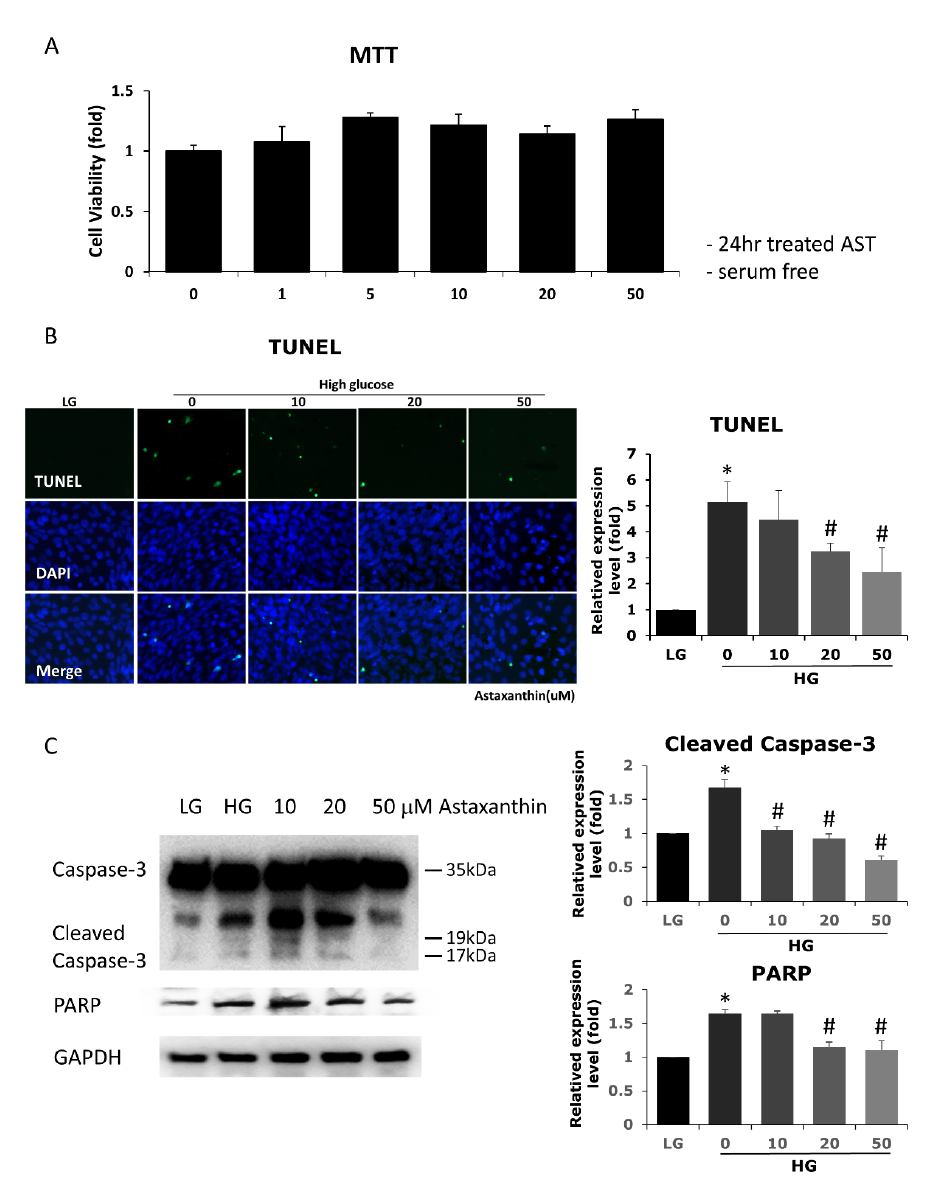
Figure 1. Effects of AST on cell viability and high glucose-induced apoptosis in 661W cells. ( A ) Cell viability was evaluated using MTT assay upon treatment with di ff erent concentrations of AST for 24 h. AST-treated and control cells showed similar cell viability. ( B ) Increased cell apoptosis was noted under high glucose environment, demonstrated by TUNEL assay and protein expression (western blots, C ). AST reduced apoptosis at 20 and 50 µ M concentration. ( C ) Decreased cleaved caspase-3 and PARP protein expression seen in western blots indicated that apoptosis was attenuated by AST. AST = astaxanthin; HG = high glucose; LG = low glucose; MTT = 3-(4,5-dimethylthiazol-2-yl)-2,5-diphenyltetrazolium bromide; TUNEL = terminal deoxynucleotidyl transferase dUTP nick end labeling; PARP = poly(ADP-ribose) polymerase; GAPDH = glyceraldehyde 3-phosphate dehydrogenase. * Significantly di ff erent from control group ( p < 0.05); # significantly di ff erent from high glucose-treated group without AST ( p < 0.05). The Mann–Whitney U test was used to calculate the di ff erences between the means of di ff erent experimental groups (three repeats per experiment, three wells per repeat, five images per well